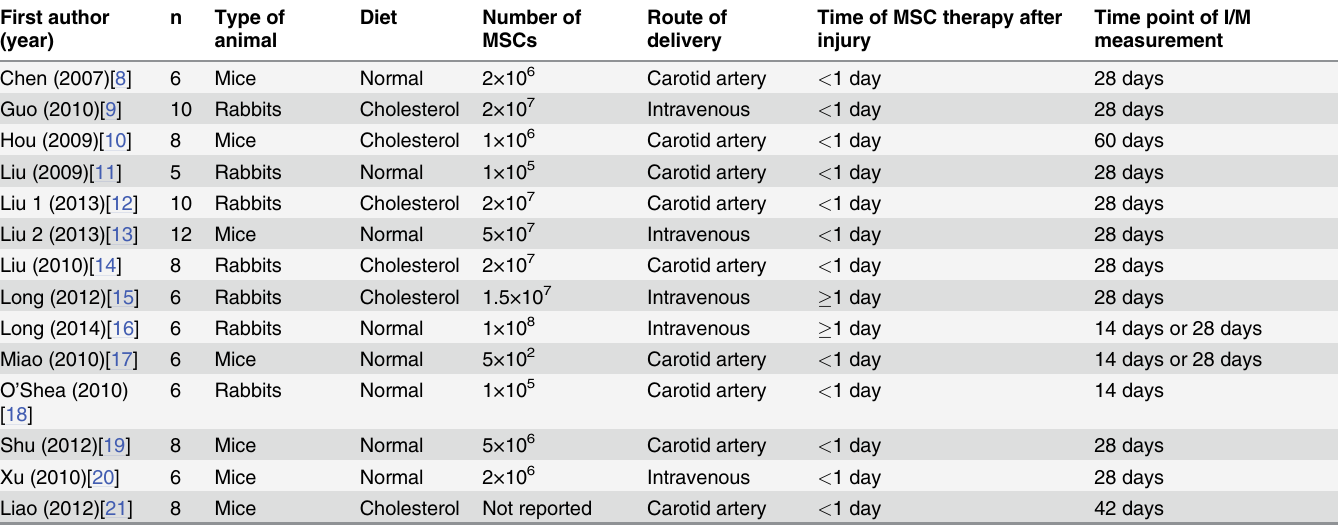
Table 1. Characteristics of the animal studies included in the meta-analysis.